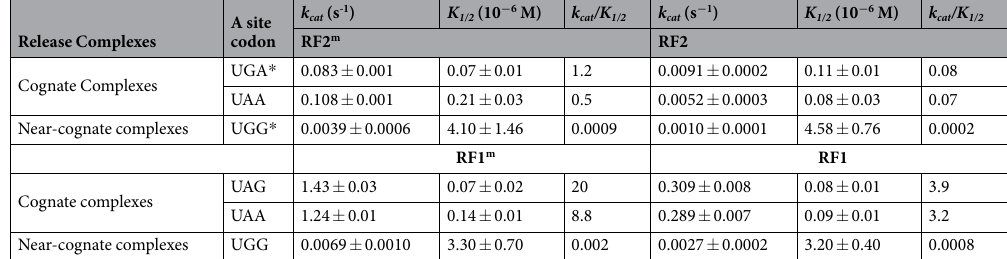
Table 1. Kinetic parameters of peptide release by methylated and unmethylated release factors on cognate and near-cognate stop codons in the E. coli ribosome in vitro . * Data were taken from the previous study 20 for the purpose of comparison. Catalytic rate constants k cat and values of K 1/2 were obtained by fitting the observed rates against the corresponding release factor concentrations to the Michaelis–Menten equation. An average of three independent measurements is reported for each reaction and errors are calculated by standard error